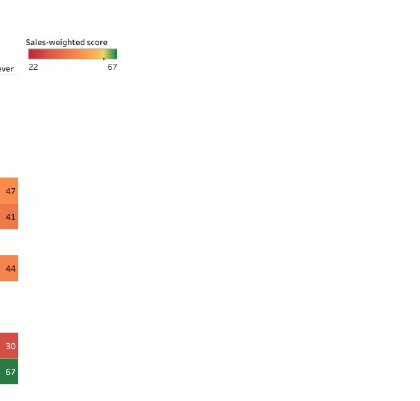
Fig 3. Sales-weighted nutrient profiling score by company and category,